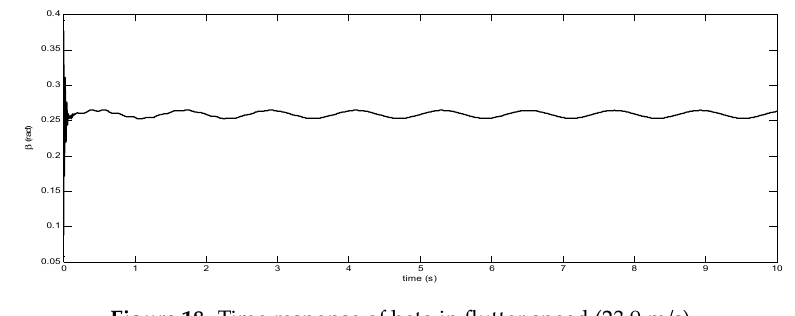
Figure 17. Time response of alpha in flutter speed (23.9 m/s).